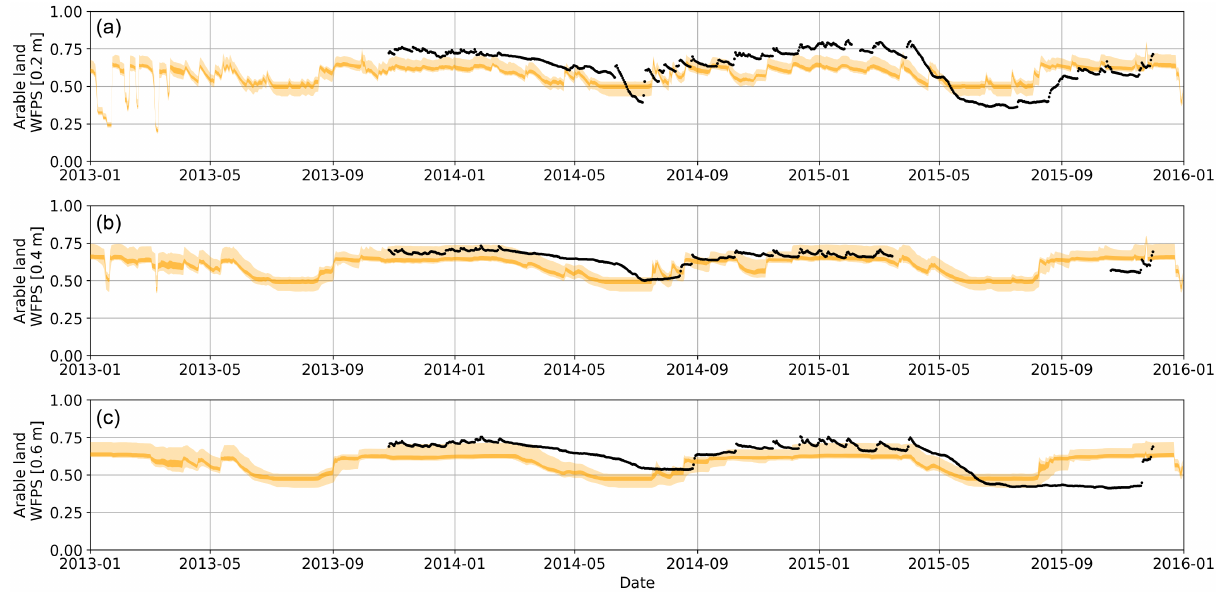
Figure A1. Modelled WFPS on arable land in different depths. RM- SEs ranging from 0.0774 to 0.1194% WFPS (0.2m), 0.0511 to